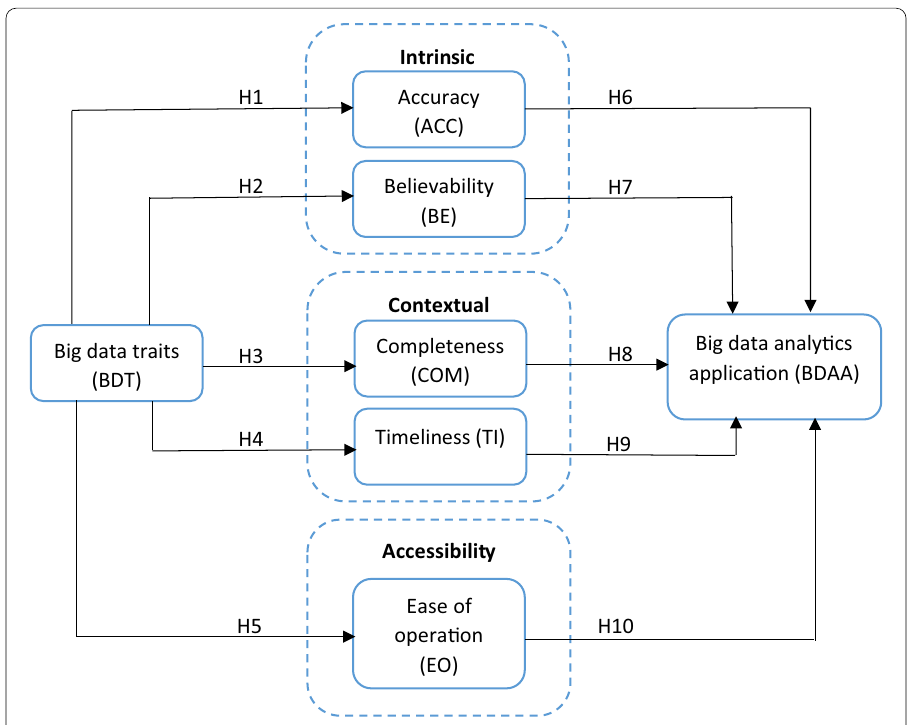
Fig. 1 The proposed conceptual model for BDA